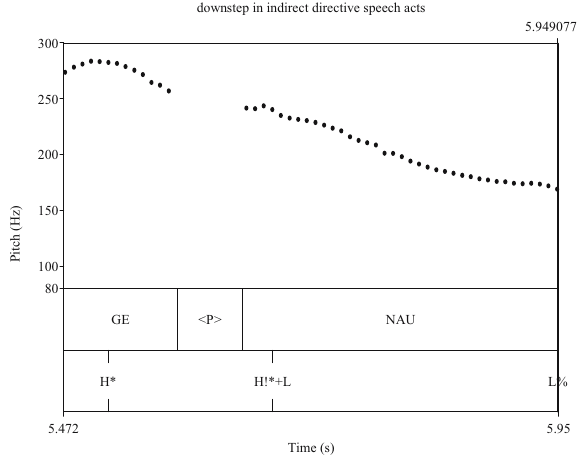
Figure 9: Word - splitting in